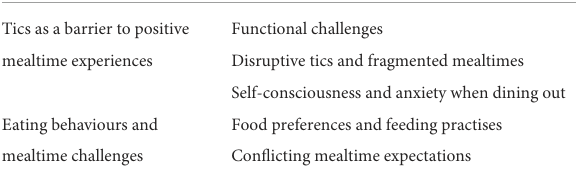
TABLE 2 Theme structure for mothers of young people with TS. Superordinate themes